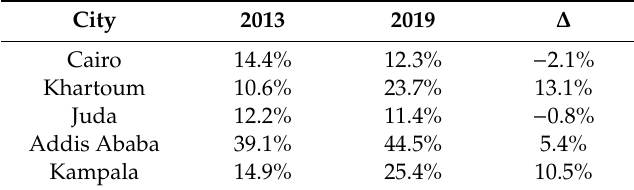
Figure 7. The Landsat-8 true color composite images and corresponding impervious surface (red as 100% and green as 0%) maps in the year 2013 and 2019, for the selected cities including Cairo, Addis Ababa, Juba, Kampala and Khartoum. Table 3. The changes of impervious surface areas (value > 50%) in selected cities.